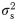
Complementary methods for determining the optimal nonlinearity.A: We use simulations to find the sigmoidal nonlinearity that minimizes the mean squared error (MSE) of a linear readout of the stimulus. We sweep over multiple possible slope and offset combinations to find the optimal nonlinearity. MSE is given in units of the stimulus variance, σs2. B: Using the same method as A, we maximize the mutual information (MI) between stimulus and responses. MI is given in units of bits. C: Optimal sigmoidal nonlinearities (blue and purple curves) found from simulations versus the optimal nonlinearity determined by solving the model analytically (gray curve). The analytical solution is determined non-parametrically, and was not chosen to be piecewise linear. All nonlinearities are qualitatively similar, regardless of the criterion for optimality or constraints on the functional form of the nonlinearity.